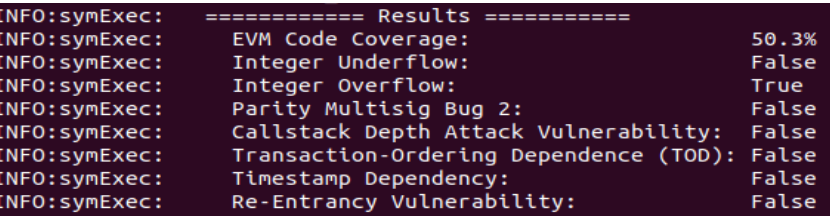
Figure 12. Security Analysis of Proposed